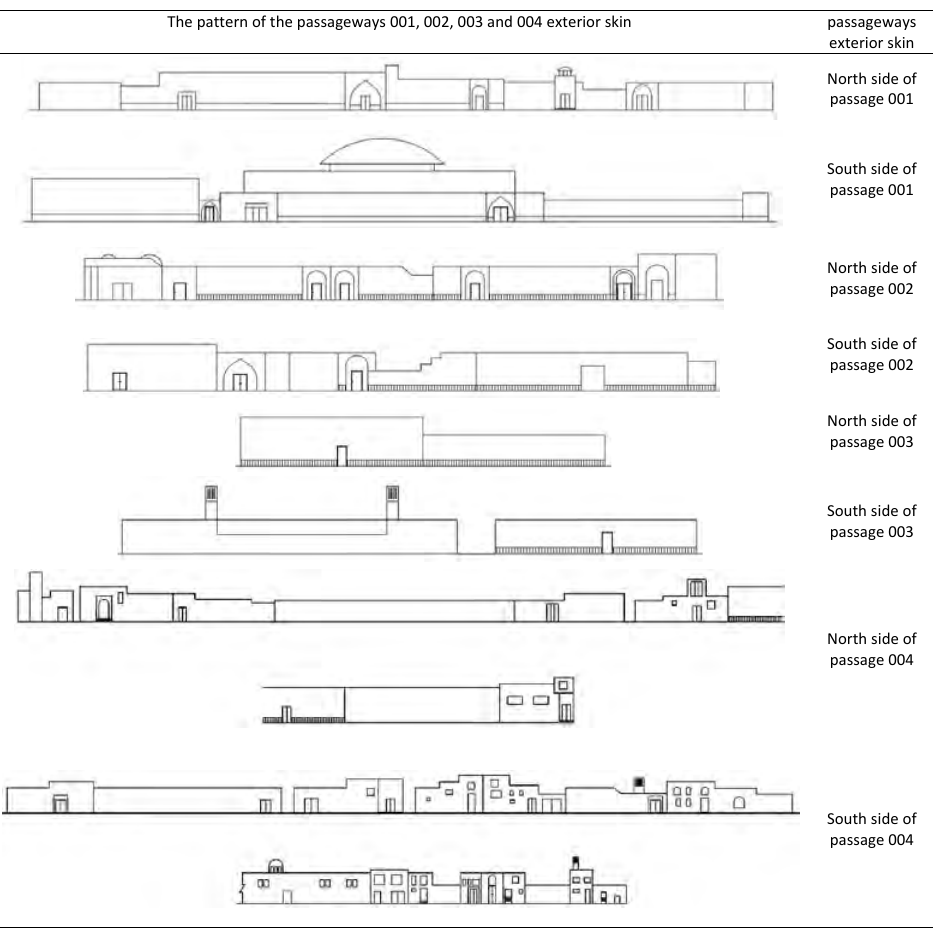
Table 10: The pattern of passageways exterior skin in Waght Al‐Saat district of Yazd